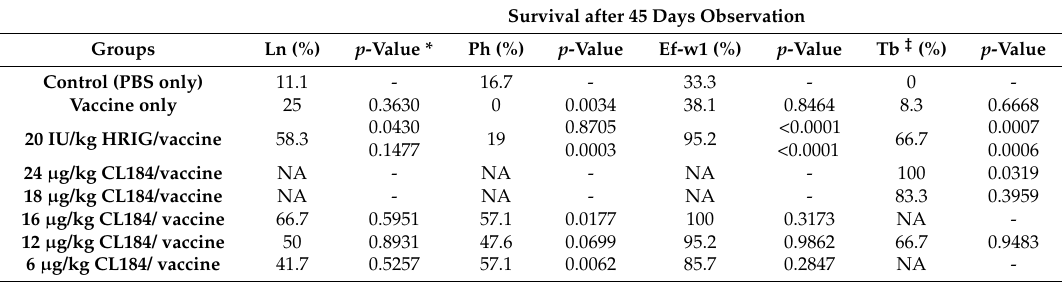
Table 3. Evaluation of the efficacy of CL184/vaccine during PEP ( p -values based on log-rank Mantel-Cox test, comparing CL184 with standard PEP regimen 20 IU/kg HRIG/vaccine).